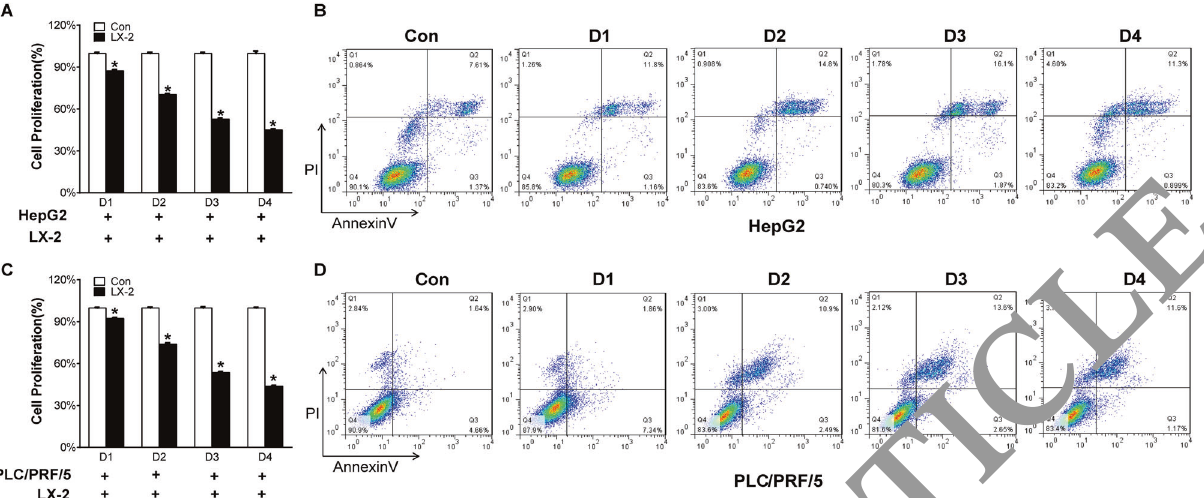
Fig. 1 Activated hepatic stellate cells in fl uence HCC cells biological functions. A HepG2 and PLC/PRF/5 cells were collected after co- cultured with LX-2 for 24 h, 48 h, 72 h, and 96 h respectively. CCK-8 assay was used to determine the viability of HepG2 and C PLC/PRF/5 cells. B Flow cytometry was carried out to analyze the apoptotic rates of HepG2 and D PLC/PRF/5 cells. All Bars, ± SD; n = 3; * P < 0.05 compared with control.